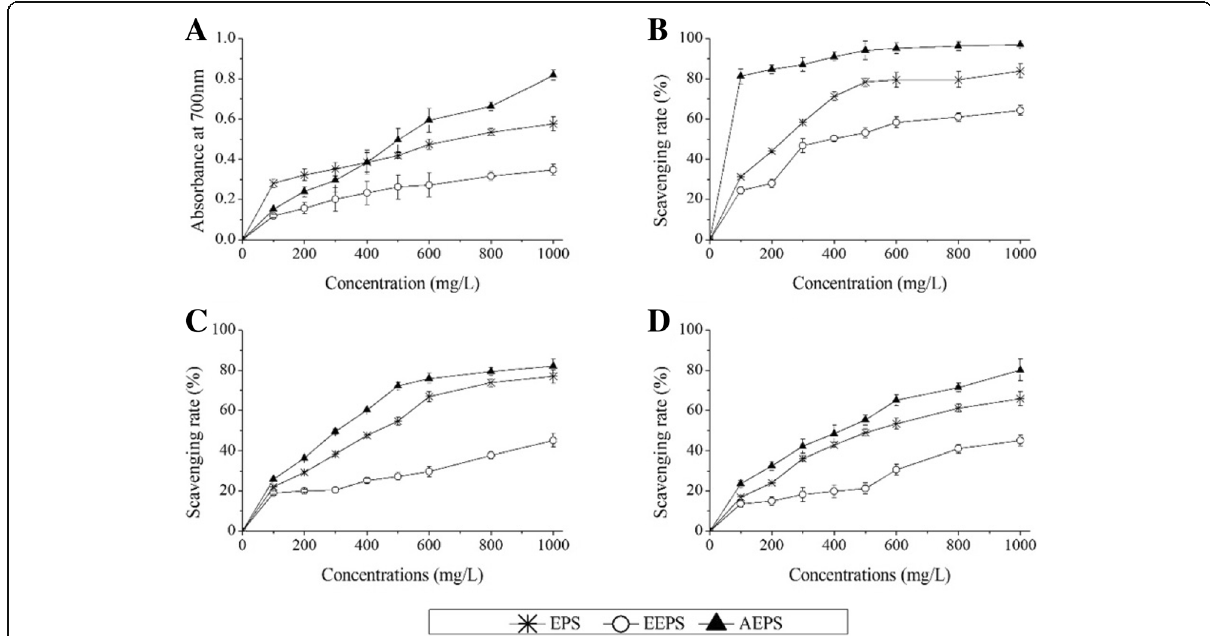
Fig. 2 Antioxidant activities of EPS, EEPS and AEPS in vitro. ( a ) reducing power, ( b ) hydroxyl radicals, ( c ) DPPH radicals, and ( d )